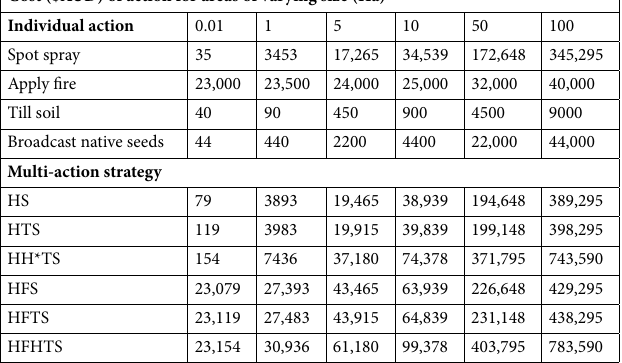
Table 7. An estimate of the cost to implement each individual control method from the plot scale to increasing size. These figures were then combined to estimate the cost of implementing each treatment over increasing size